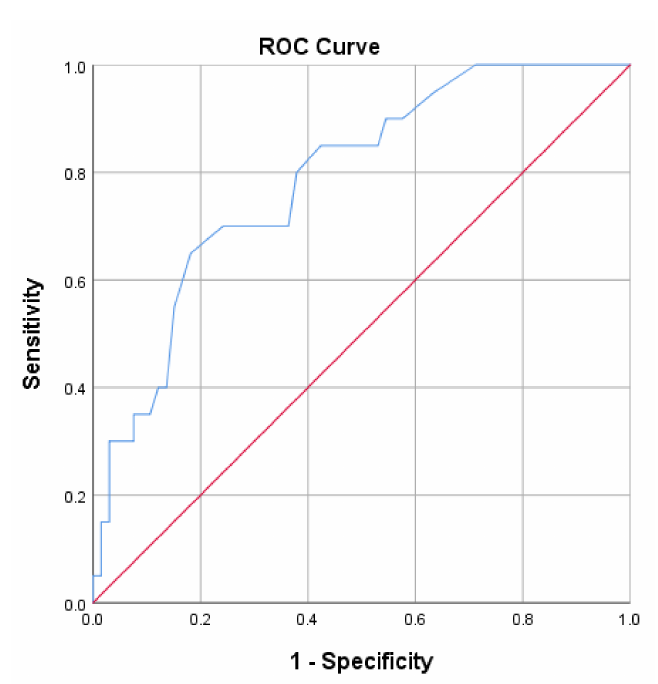
Figure 1. ROC curve of the SS-QOL-17. Stroke survivors with good prognosis on mRS were analyzed. Area under the curve = 0.787; 95% CI 0.712–0.863 ( p < 0.001). At value = 44.00, sensitivity = 70.00% and specificity =